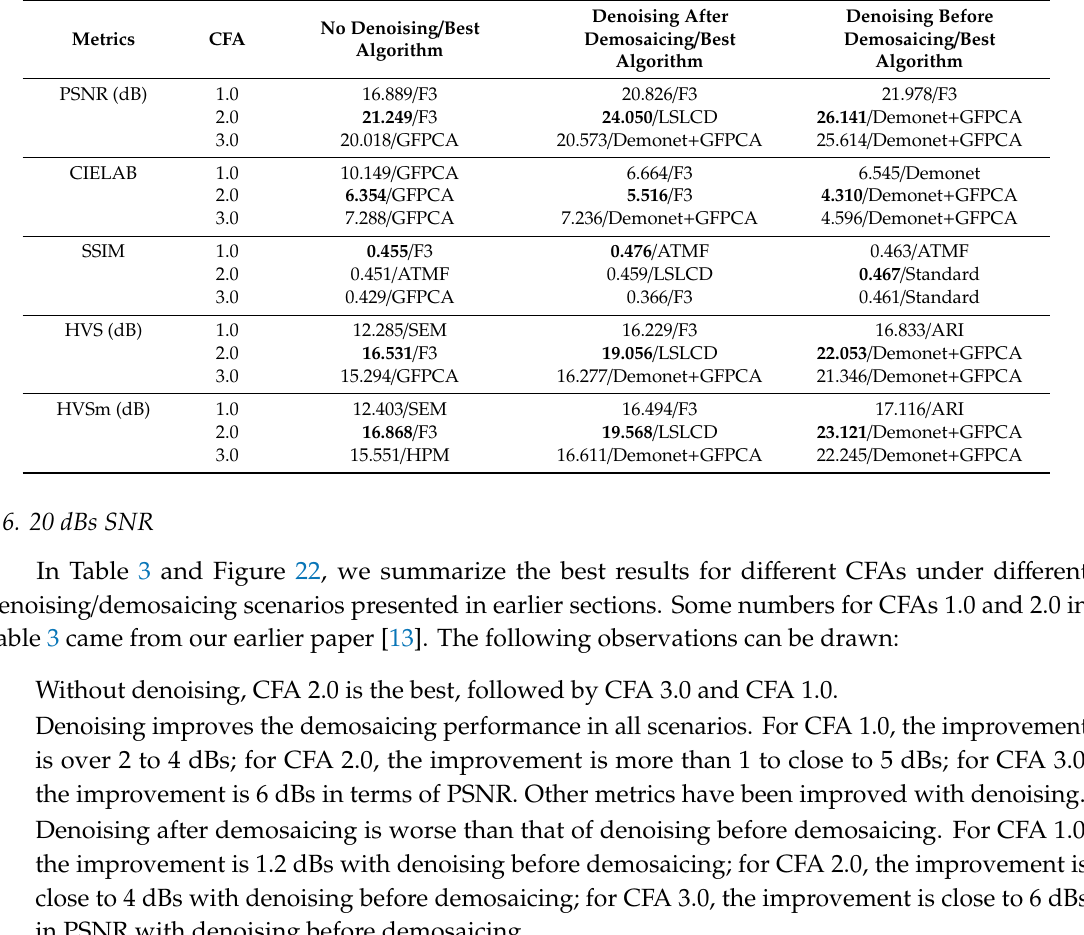
Table 2. Comparison of CFA patterns for the various demosaicing cases at 10 dBs SNR. Bold numbers indicate the best performing methods in each row.